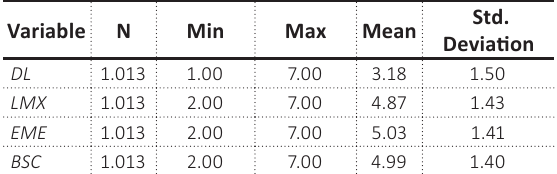
Table 1. Descriptive statistics Source: Processed results of SPSS Amos 25.